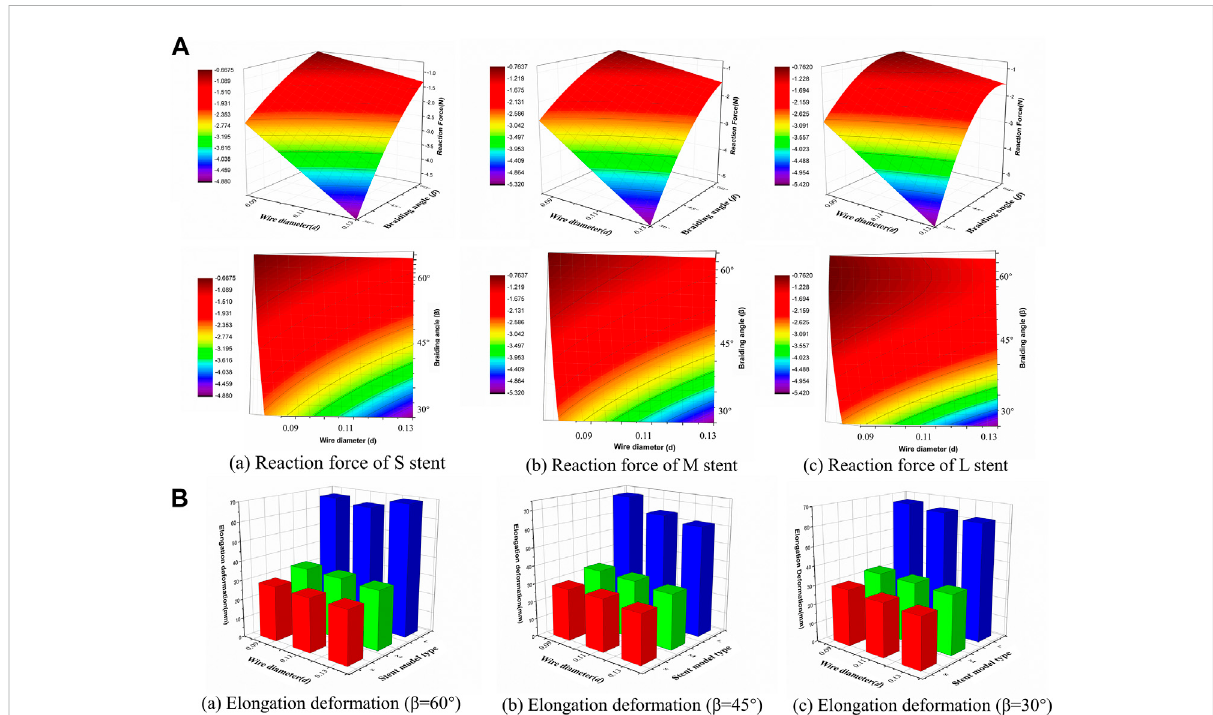
FIGURE 5 Response surface diagram of reaction force and comparison of the elongation deformation. (A) Comparison the reaction forces of different stent model types in front view/top view (a) Reaction force of S stent under different wire diameter ( d ) and braiding angle ( β ). (b) Reaction force of M stent under different wire diameter ( d ) and braiding angle ( β ). (c) Reaction force of L stent under different wire diameter ( d ) and braiding angle ( β ). (B) Comparison of the elongation deformation of stent with 60 ° /45 ° /30 ° braiding angle